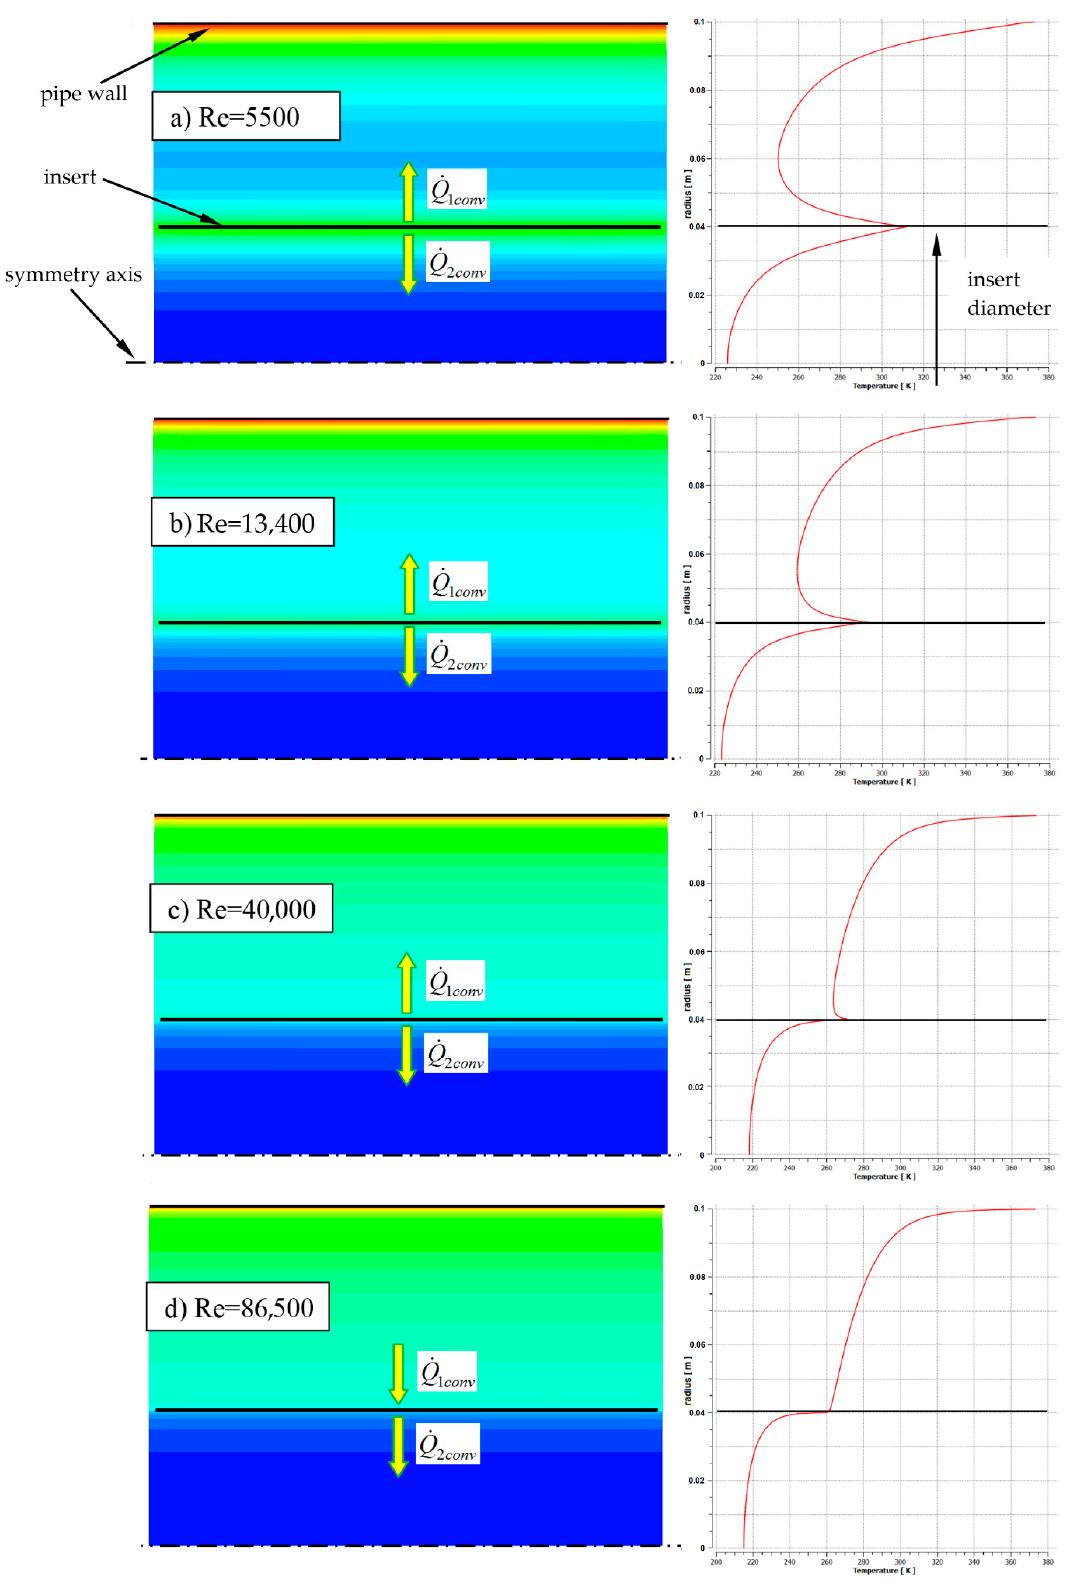
Figure 8. Temperature fields and profiles in the pipe cross-section for an exemplary insert with a diameter of D = 0.4 and several Re numbers.